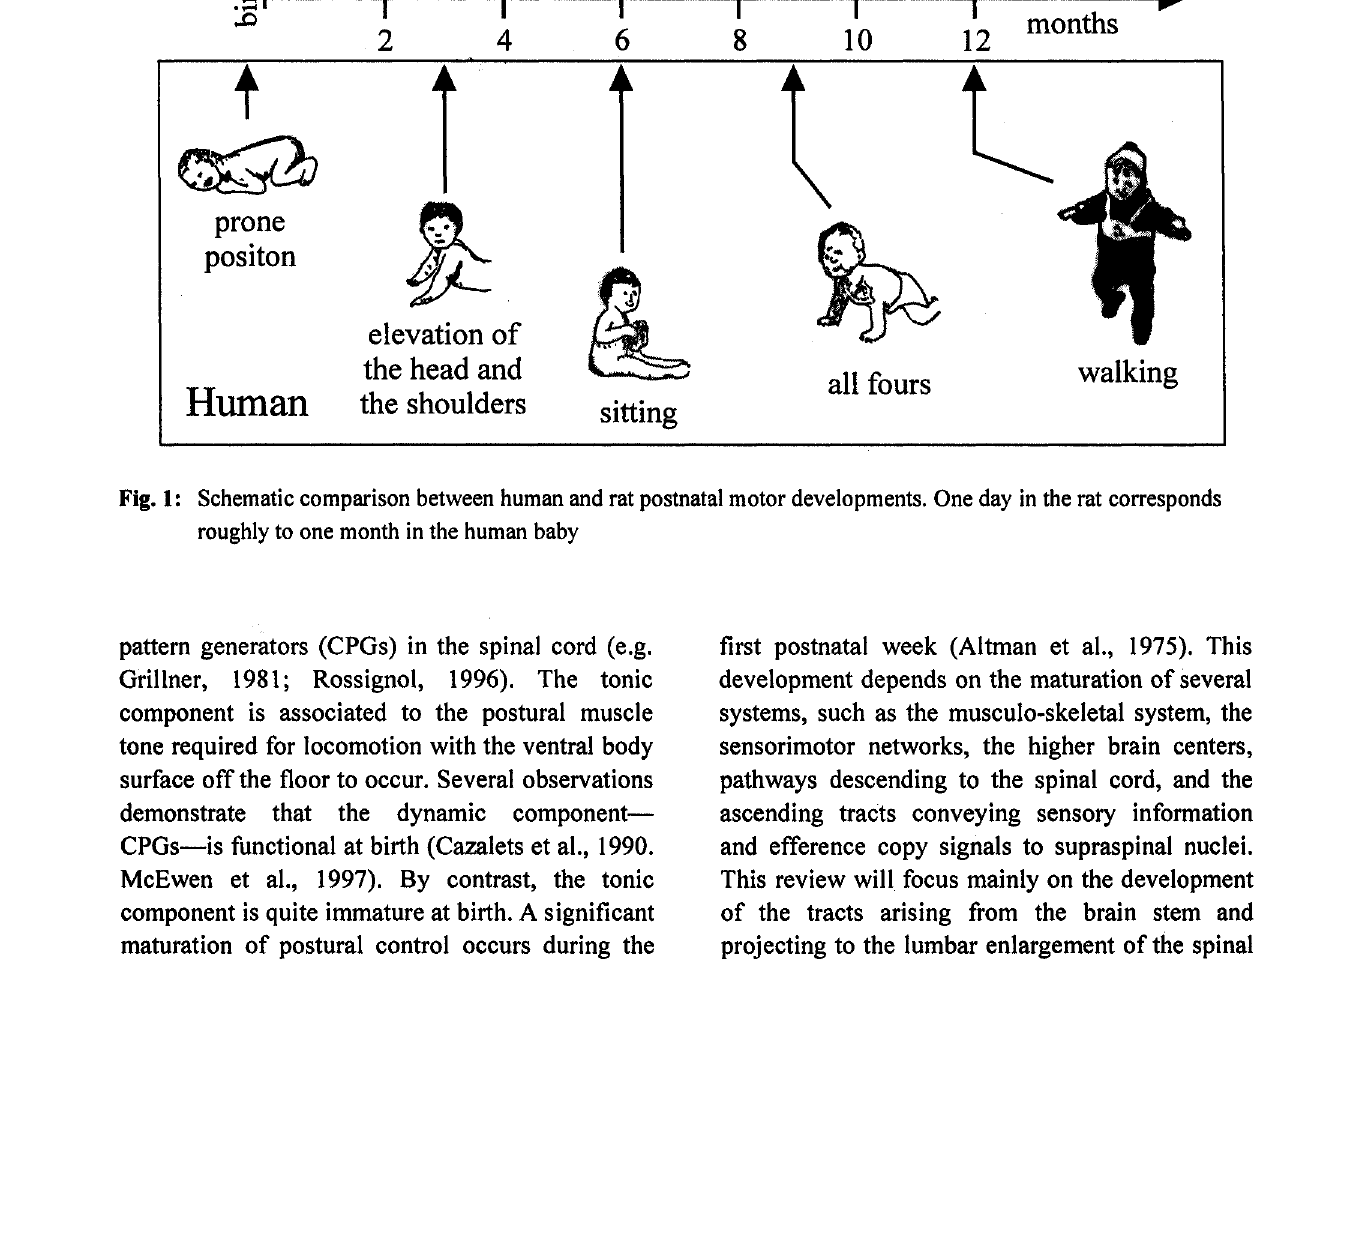
Fig. 1: Schematic comparison between human and rat postnatal motor developments. One day in the rat corresponds roughly to one month in the human baby